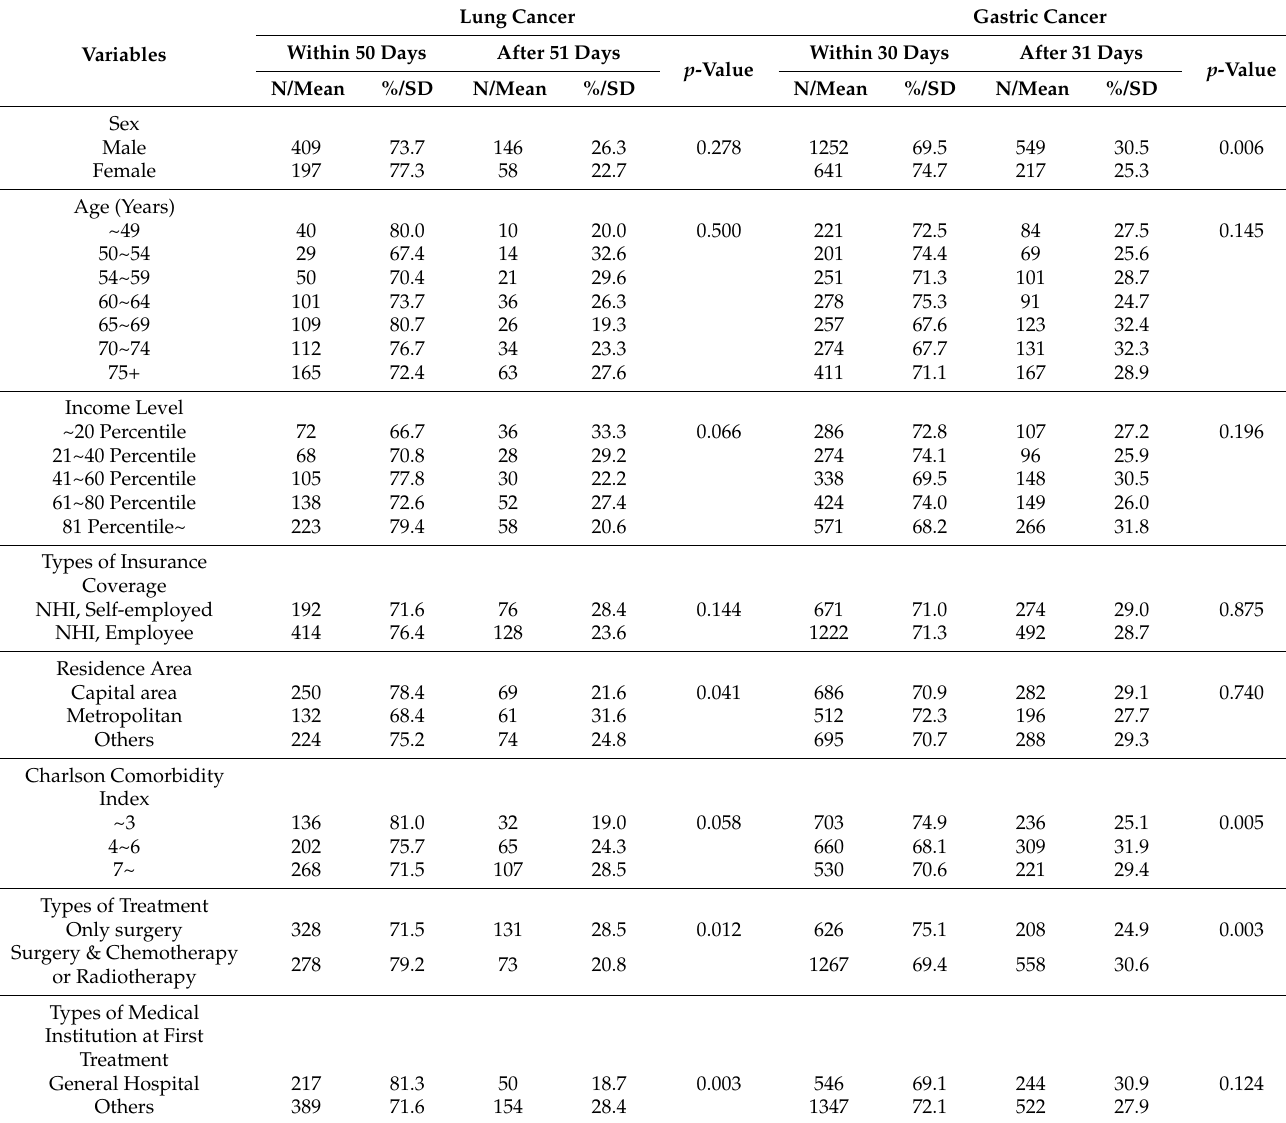
Table 1. Baseline characteristics of cancer patients with surgical